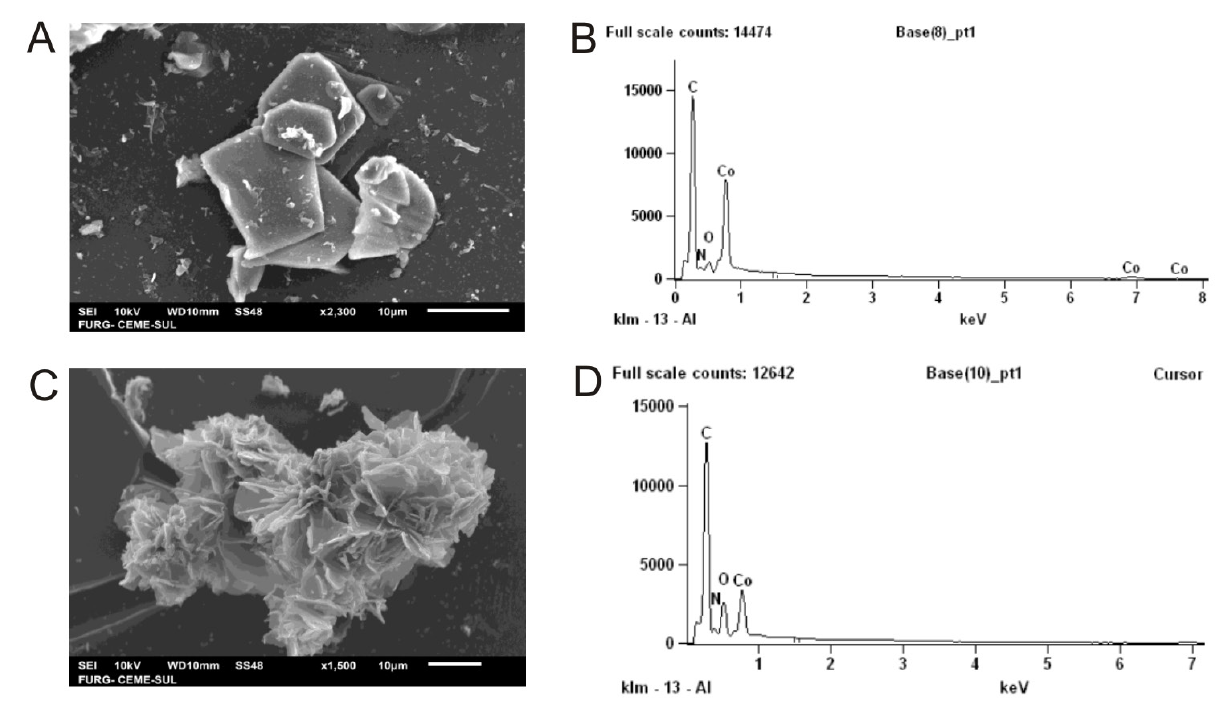
FIGURE 8 – SEM-EDS results obtained for compound 5 (A)/(B) and for compound 4